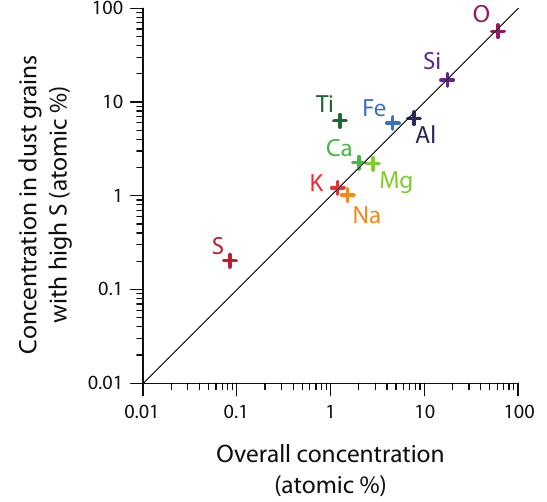
Fig. 5. Comparison of elemental composition of all dust and compo- sition of dust with 32 S count rates high enough for reliable isotopic